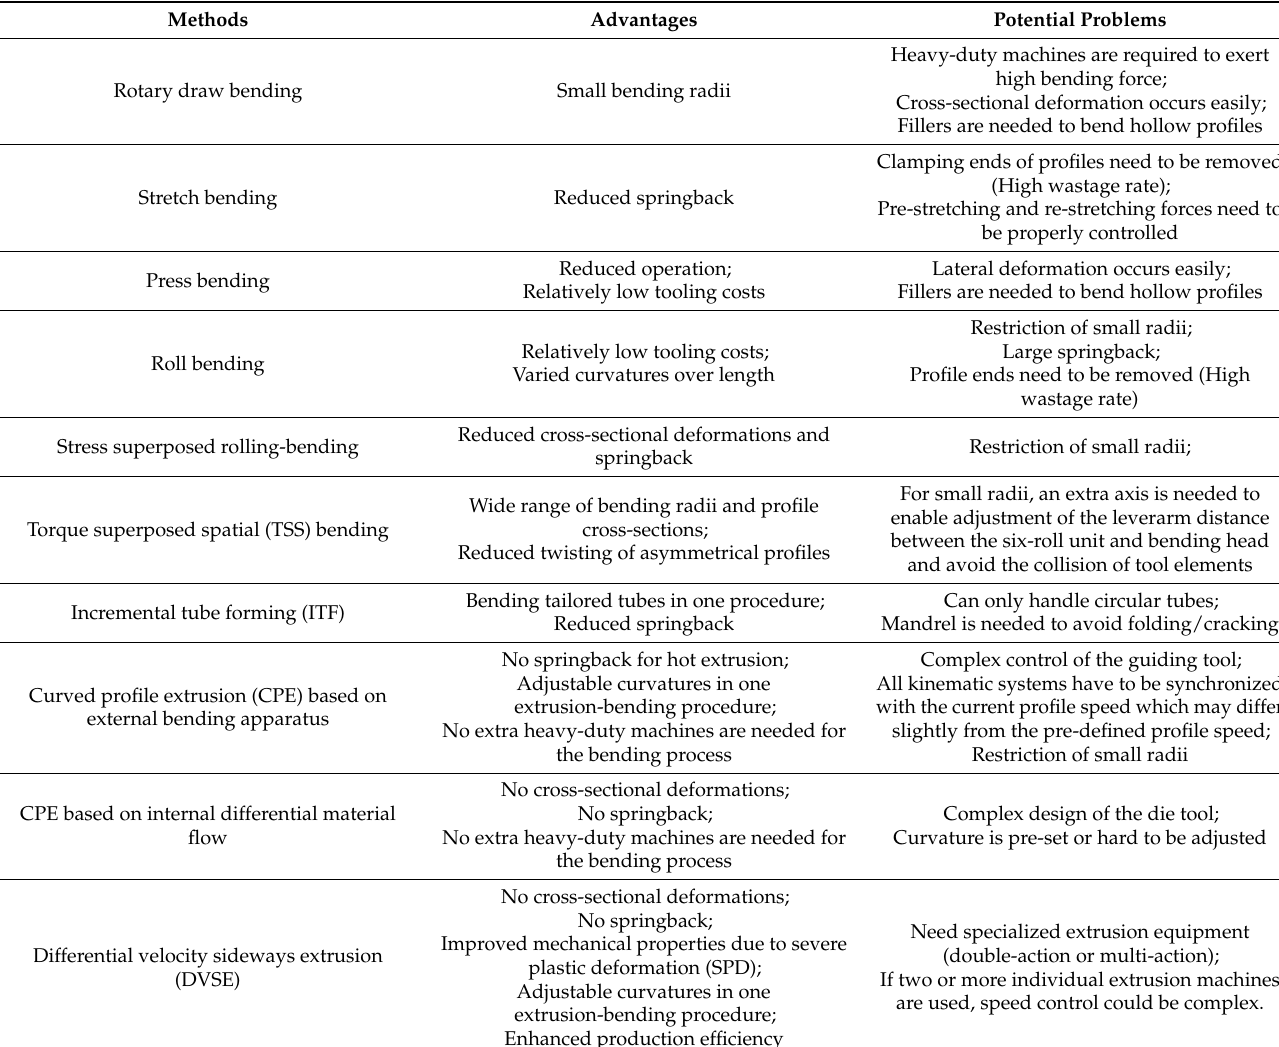
Table 2. Comparison of the curved profile forming methods.